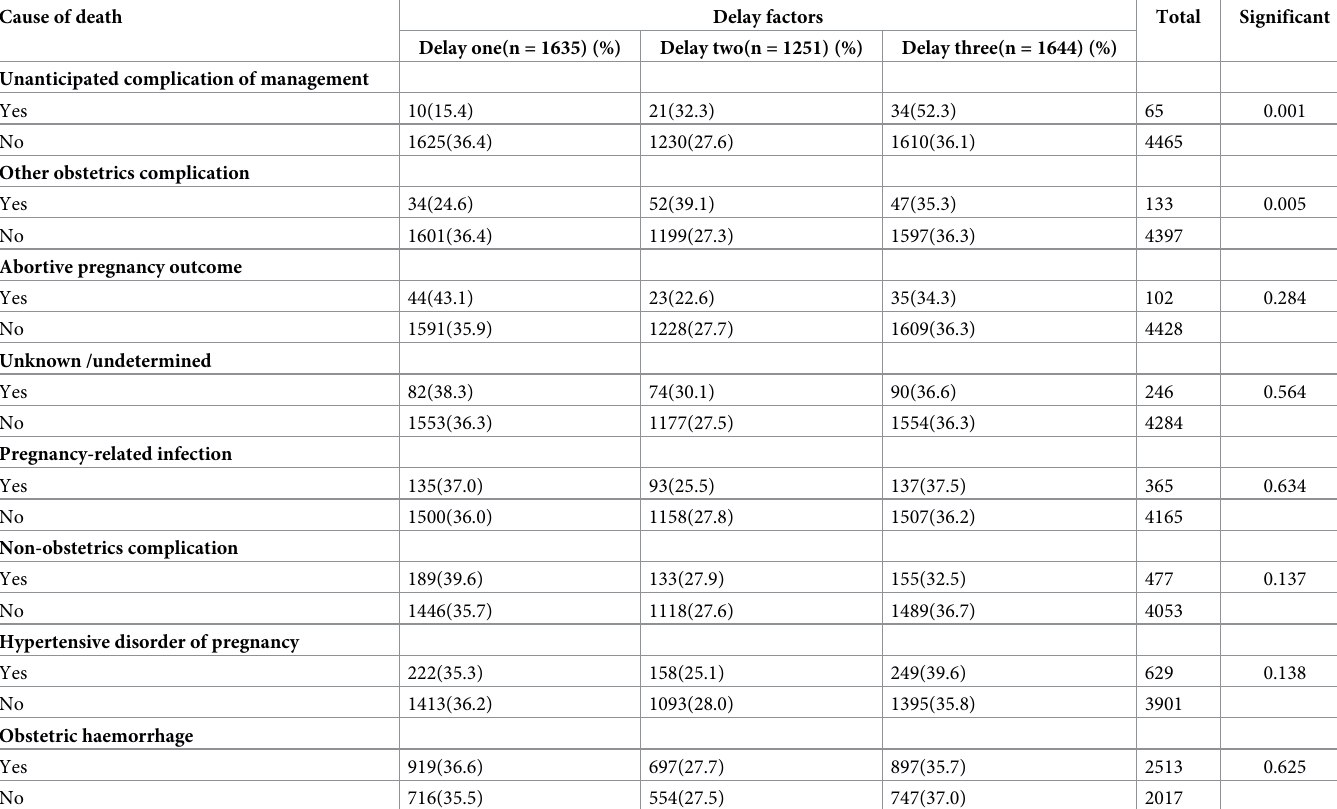
Table 3. Distribution of the cause of death by time of death among reviewed maternal death in Ethiopia, 2021. Cause of